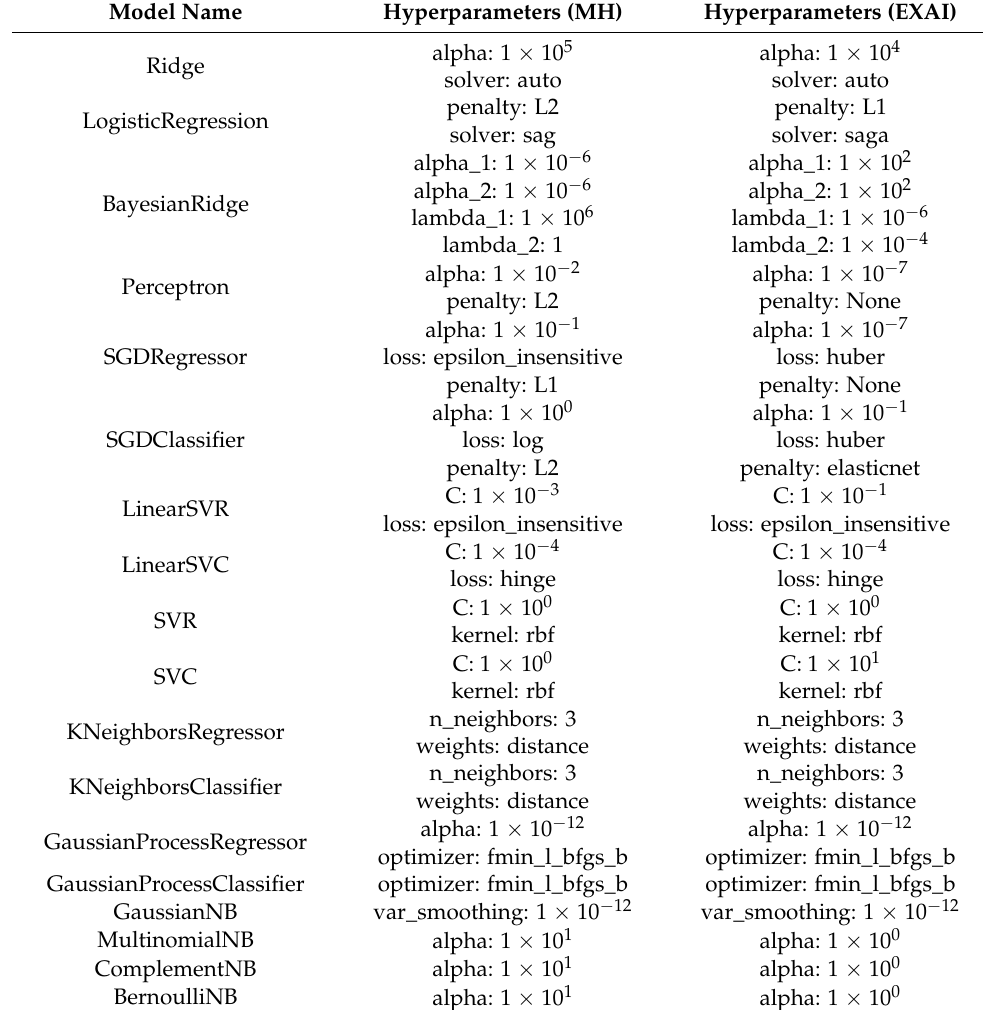
Table 4. Optimal hyperparameters for a 1:3 ratio loss function and a 50%:50% ratio of the number of training and testing